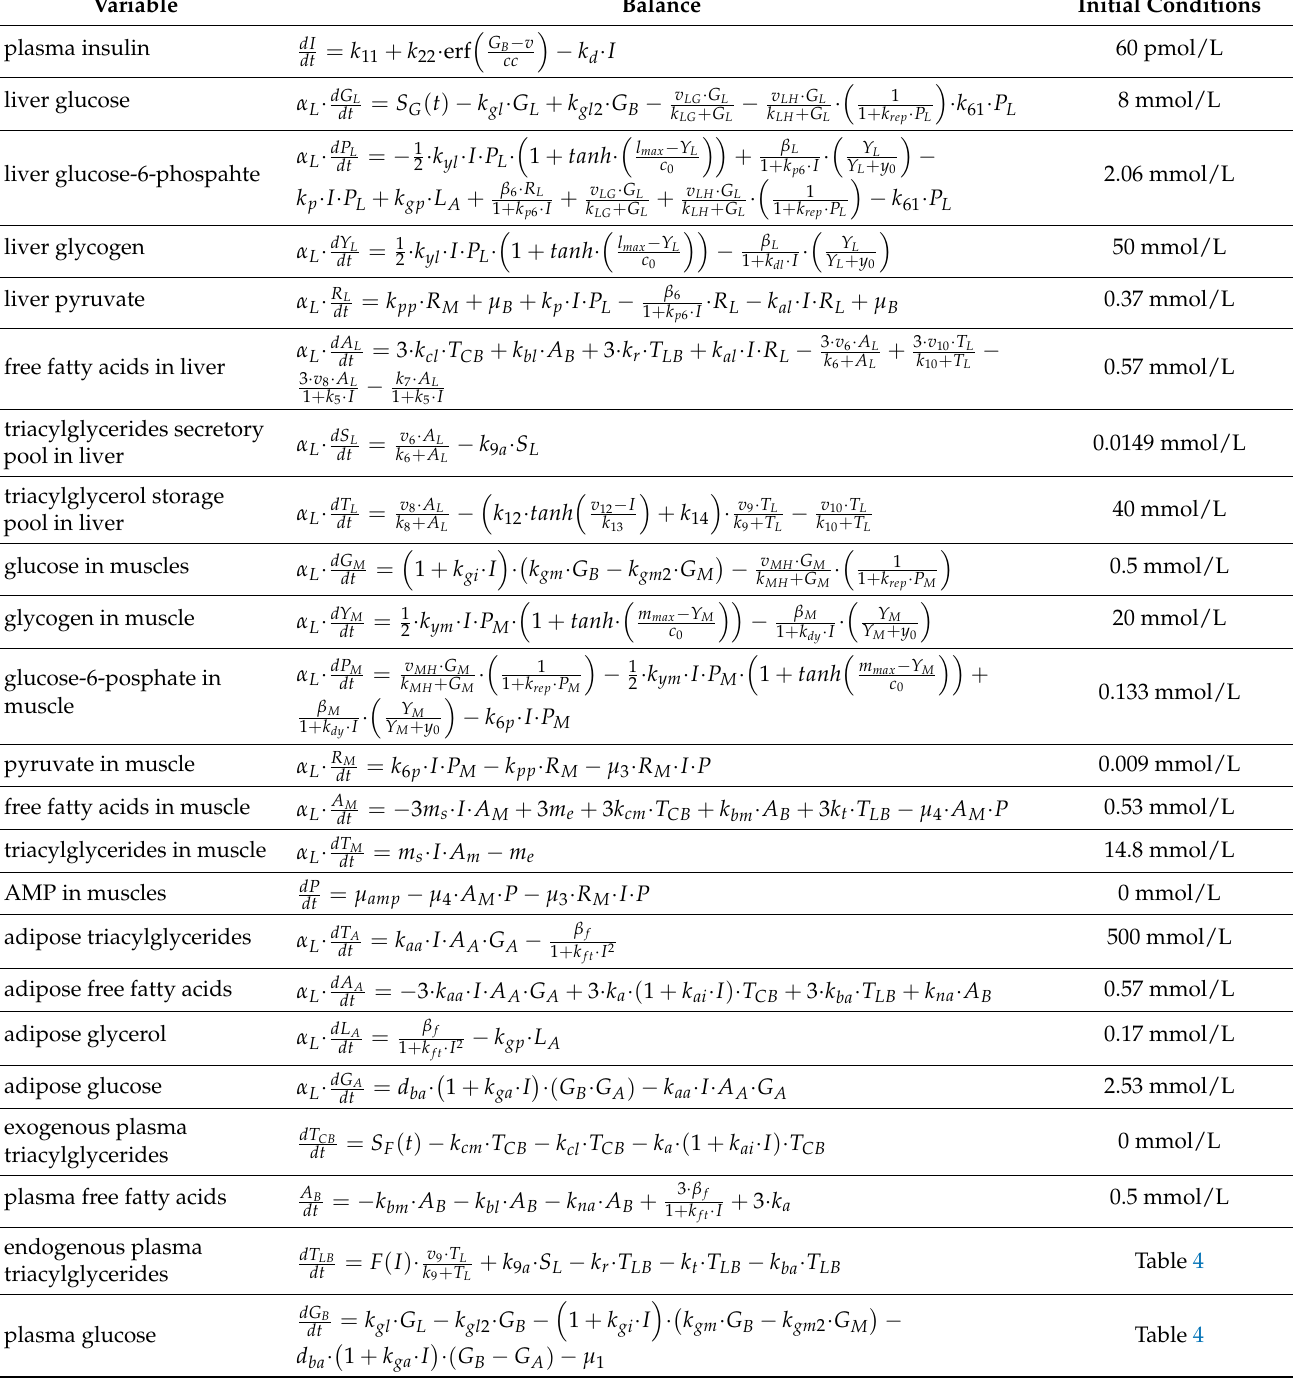
Table 2. List of hepatic lipid metabolism model balances proposed by Pratt et al.